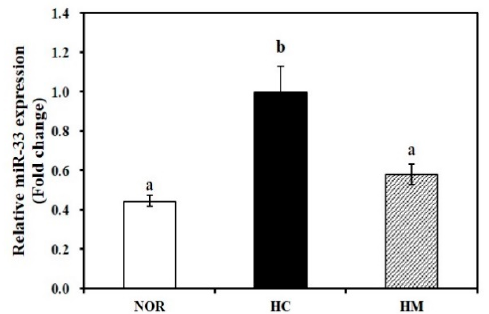
Figure 4. Effect of high hydrostatic pressure mulberry fruit extract on hepatic miR-33 expression. Hepatic miR-33 levels were measured by RT-qPCR, normalized to U6 snRNA, expressed as the fold change compared to the HC group, and expressed as mean ± SEM ( n = 6). Mean values with different superscript (a, b) are significantly different at p < 0.05. NOR, normal diet; HC, high cholesterol/cholic acid diet containing 1% cholesterol and 0.5% cholic acid; and HM, HC + 0.4% high hydrostatic pressure mulberry fruit extract.